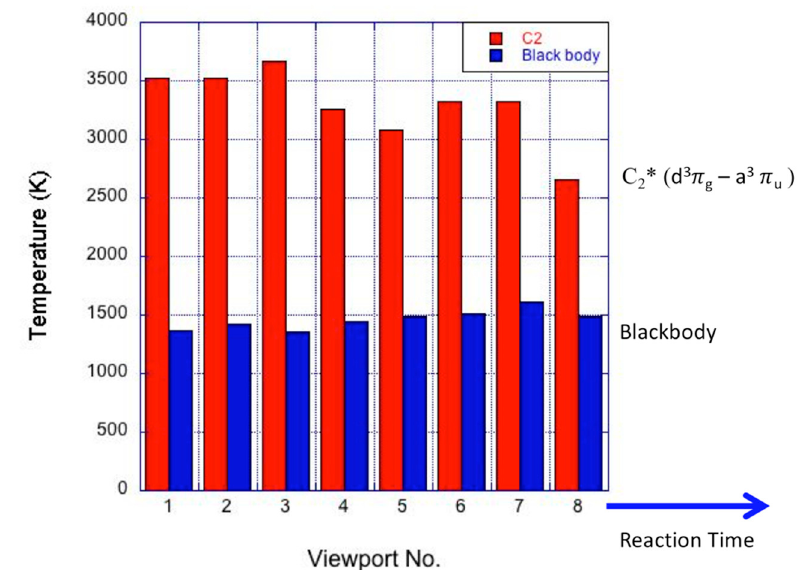
Figure 8. Temperature profiles along the reactor, based on blackbody fit to spectral radiance and by fit to the C 2 Swan band emission (d 3 (cid:2024) g − a 3 (cid:2024) u ) system, across the vibrational bands, as shown in Figure 7